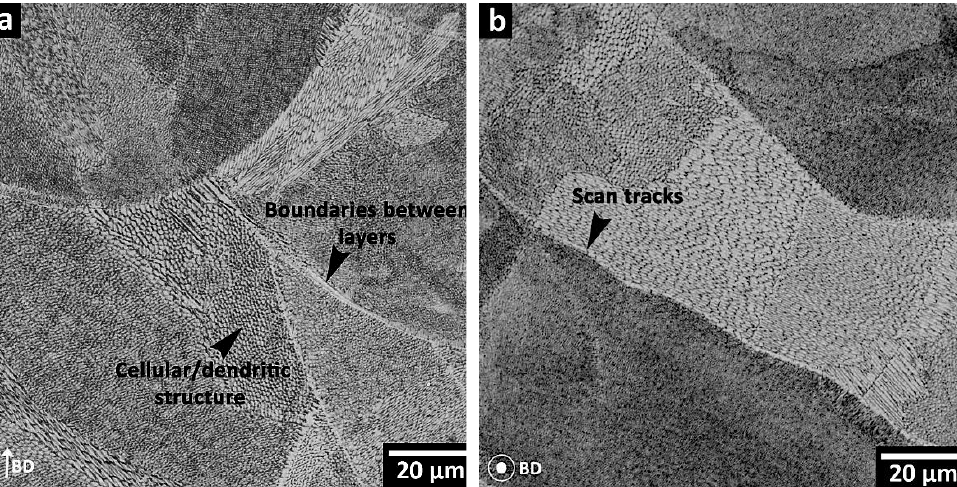
Figure 9. Representative optical microscopy images in as-built 316LSS ( a ) along the BD and ( b ) nor- mal to the BD (TD).